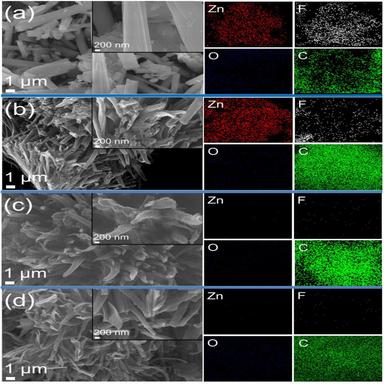
SEM and corresponding elemental mapping images of (a) Zn-TFBDC, (b) ZnO/PC, (c) PC and (d) APC samples.